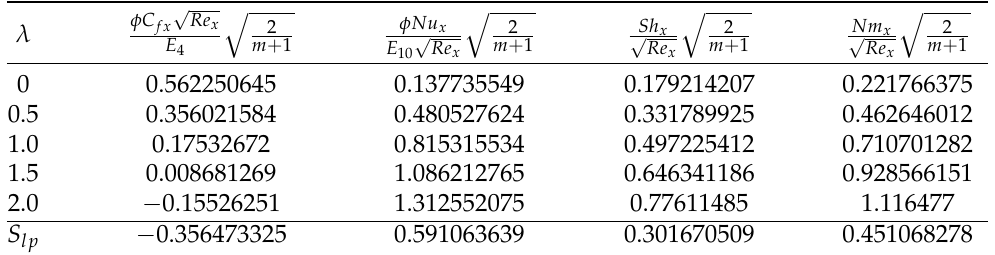
Table 5. Variation of physical quantities for case 2—smaller thermal conductivity of nanoparticles when η ∞ = 5.